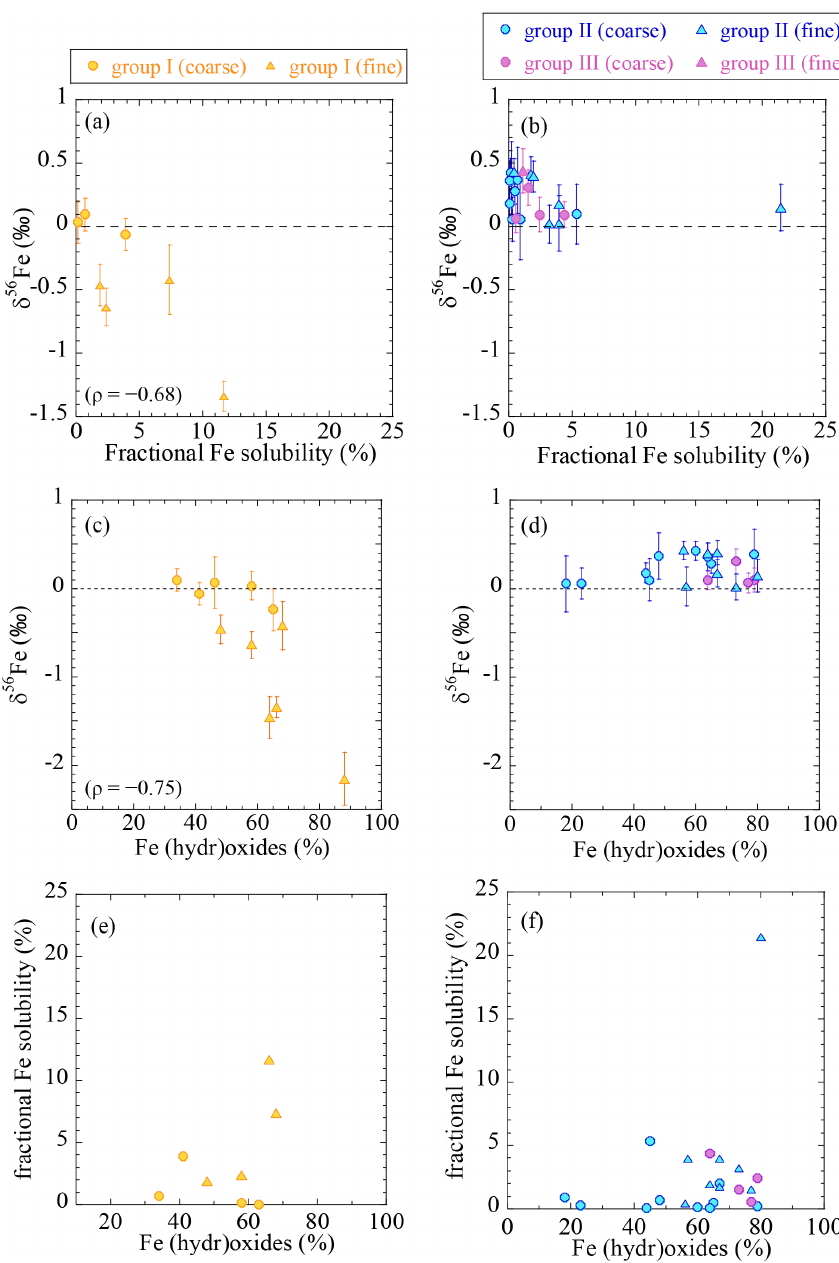
Figure 8. The relationships between (a, b) the fractional Fe solubility and δ 56 Fe; (c, d) the fraction of Fe (hydr)oxides and δ 56 Fe; and (e, f) the fraction of (hydr)oxides and the fractional Fe solubility. ρ is the Spearman rank order correlation coefficient ( p< 0 . 05). ∗ Only for fine particles. Yellow, group I; blue, group II; purple, group